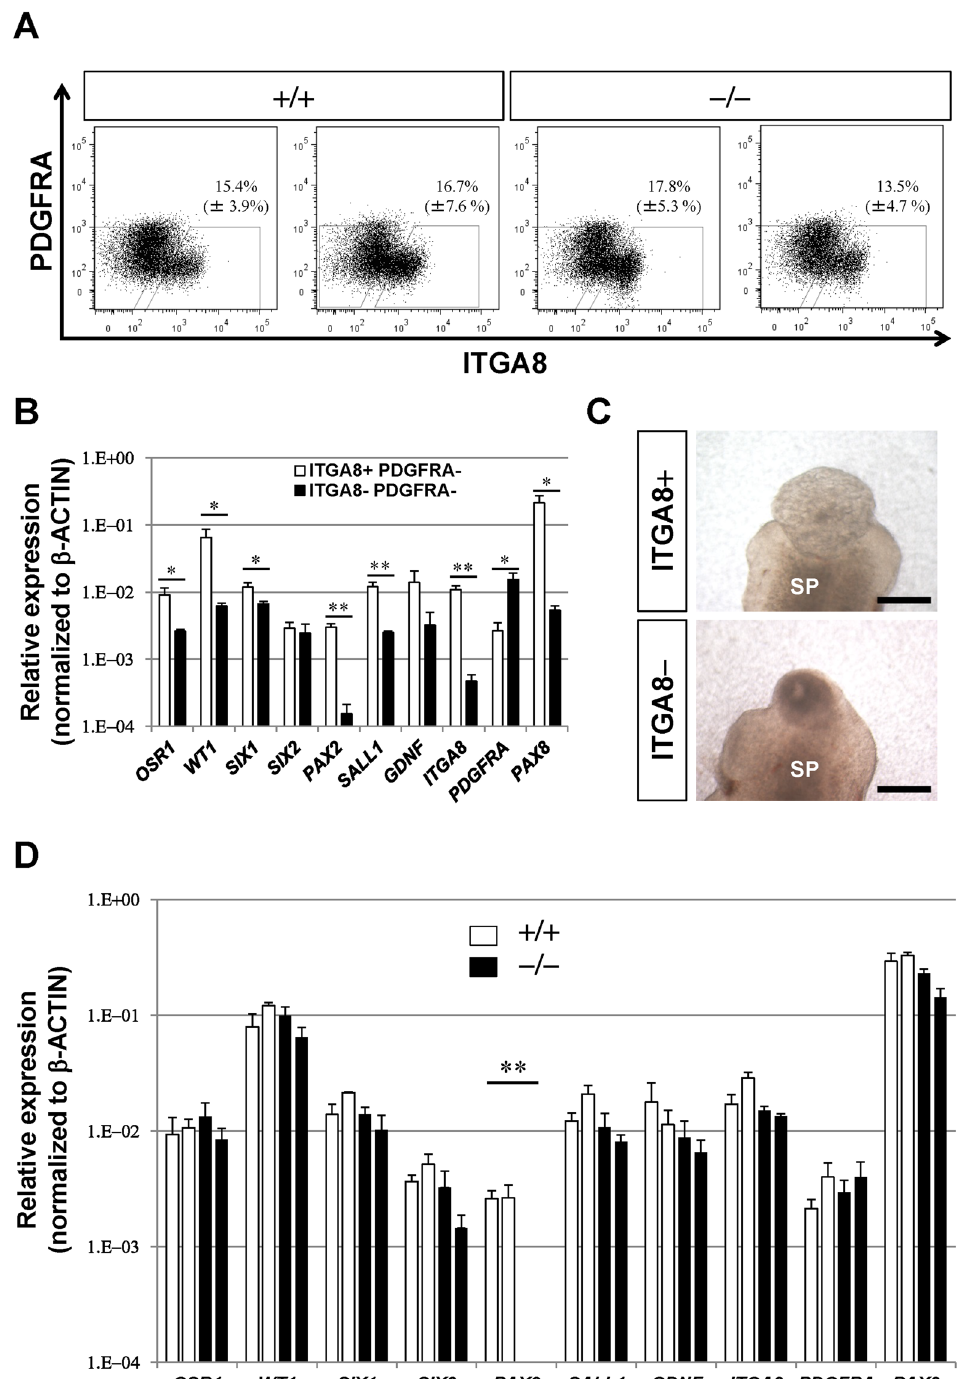
Figure 3. Nephron progenitors are generated from PAX2 -null iPS cells. ( A ) FACS analysis of tissues induced from wild-type ( + / + ) and PAX2 -null ( − / − ) iPS cells. The percentages of the ITGA8 + /PDGFRA − nephron progenitor fraction from three independent induction experiments are determined (mean ± standard error). ( B ) Nephron progenitor markers are more abundantly expressed in the ITGA8 + /PDGFRA − fraction (open bars) than in the ITGA8 − /PDGFRA − fraction (closed bars) induced from the wild-type clone. Data represent mean ± standard error of three independent induction experiments. * p < 0.05, ** p < 0.01. ( C ) Tubulogenesis is observed when the ITGA8 + /PDGFRA − fraction is co-cultured with spinal cord for 9 days. SP: spinal cord. Scale bars: 200 µ m. ( D ) Expression levels of nephron progenitor markers are unaltered, except for PAX2 . qPCR analyses of sorted ITGA8 + /PDGFRA − fractions from two wild-type clones (open bars) and two PAX2 -null clones (closed bars) are shown (mean ± standard error). ** p <